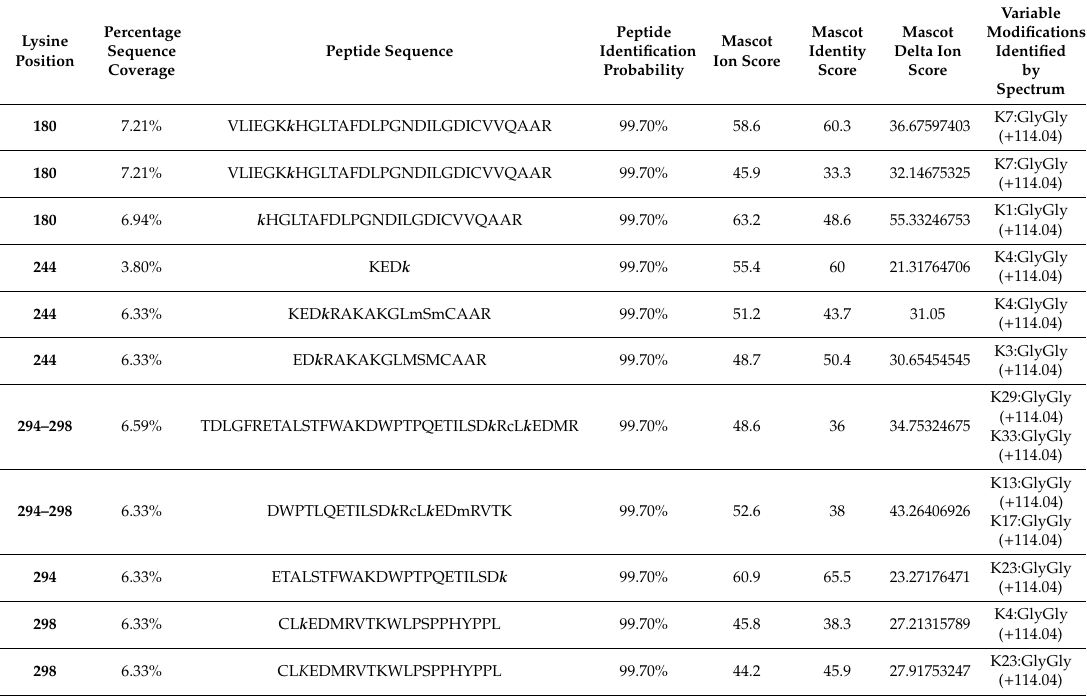
Table 1. The enriched NSs protein was analyzed by mass spectrometry in an attempt to identify lysine residues targeted for specific ubiquitination. MS2 mass spectrometry results (TLS, Siena, Italy) are reported, showing the identification of TOSV NSs peptide containing the ubiquitinated lysine residues at position 180, 244, 294, and